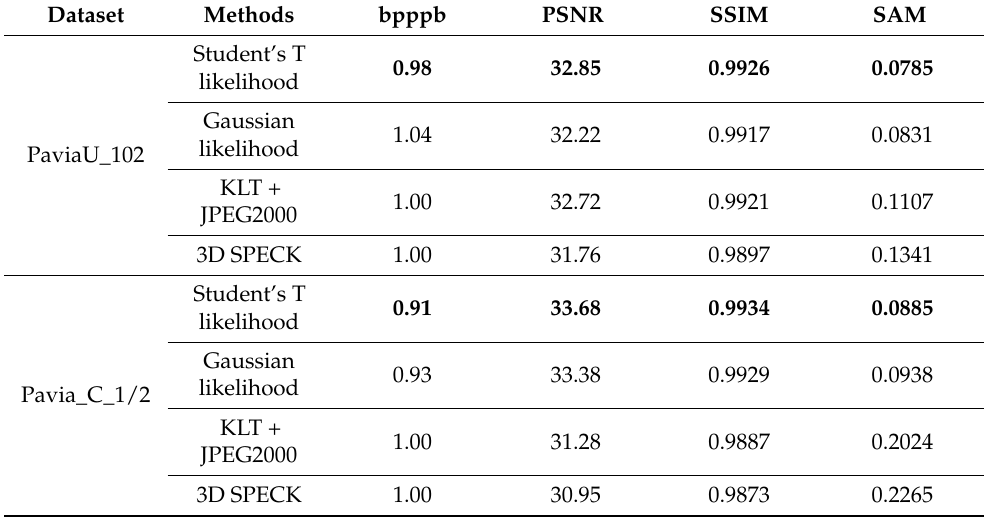
Table 3. Rate-distortion performance for relatively high bit rates; the comparatively ideal choice is marked in bold ( λ = 0.00005